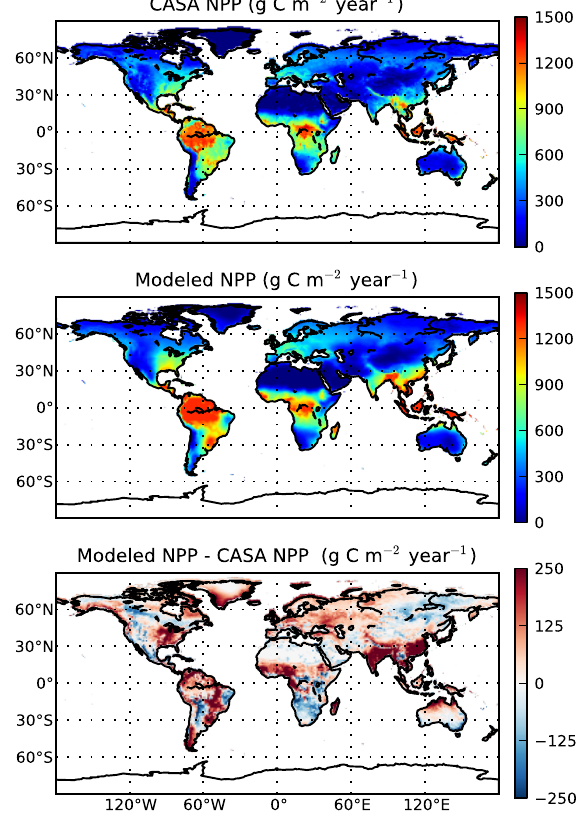
Fig. 3. NPP derived from the CASA model (top), the MAP and MAT based model (middle), and the absolute difference between the two approaches (bottom).